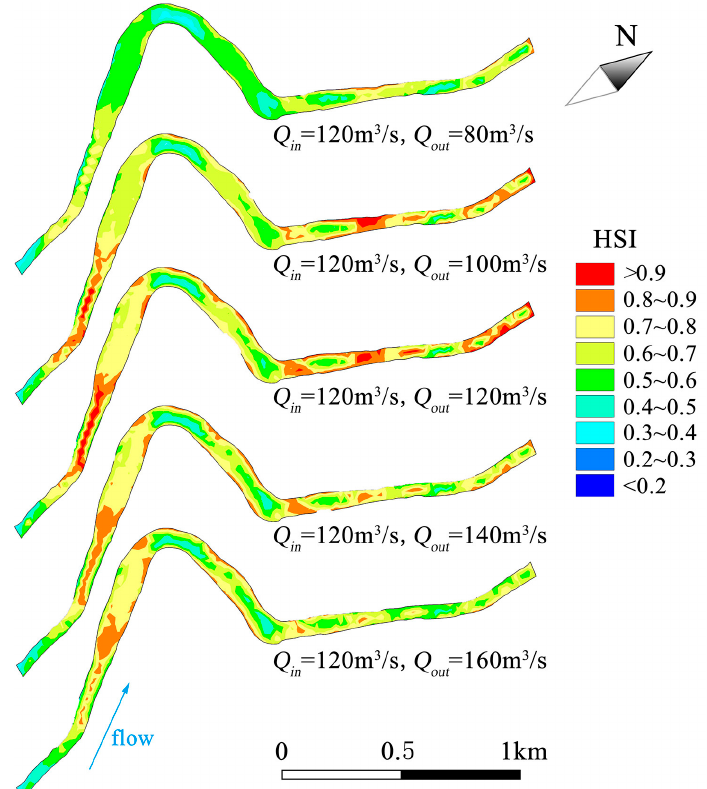
Figure 13. The spatial distribution of HSI under different outflow scenarios.